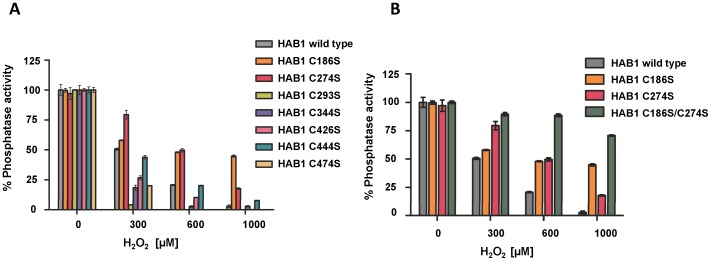
HAB1 C186S/C274S mutant protein is resistant to inactivation by H2O2.A) Relative phosphatase activities of HAB1 wild type and cysteine point mutant proteins to H2O2 treatment. B) H2O2 resistance of C186S and C274S single and double mutant proteins compared to wild type HAB1 (n = 3, error bar represent s.d.).